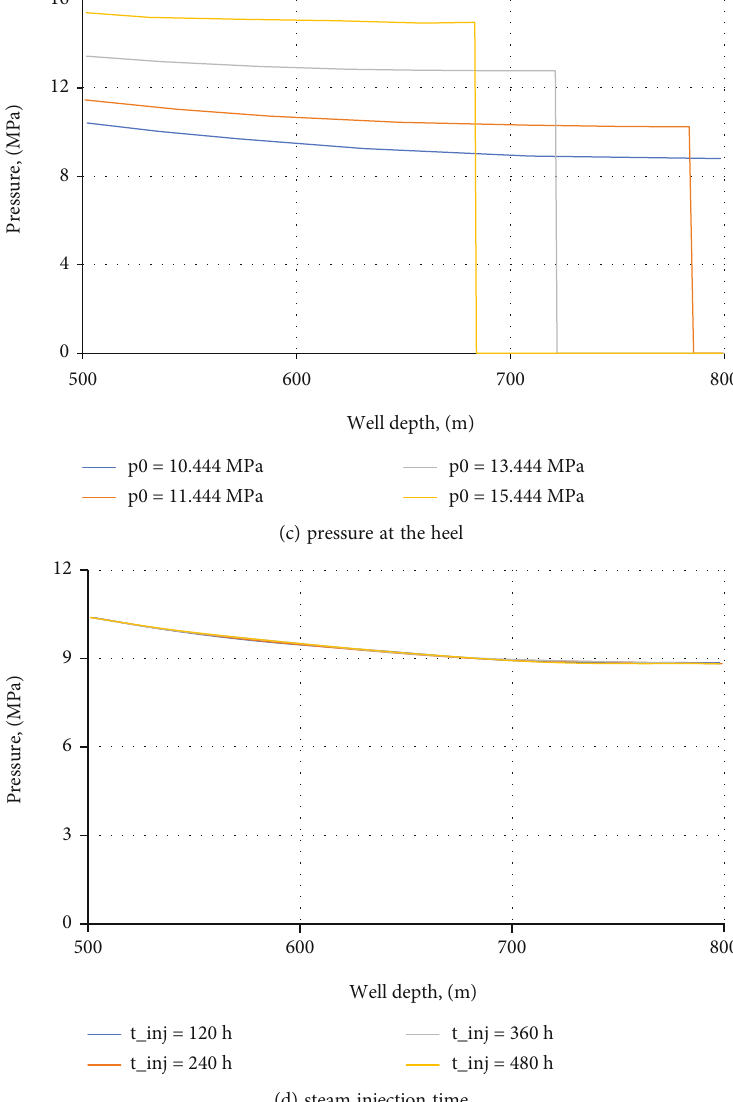
Figure 9: E ff ect of (a) steam injection rate, (b) steam quality at the heel, (c) pressure at the heel and (d) steam injection time on the distribution of pressure along the